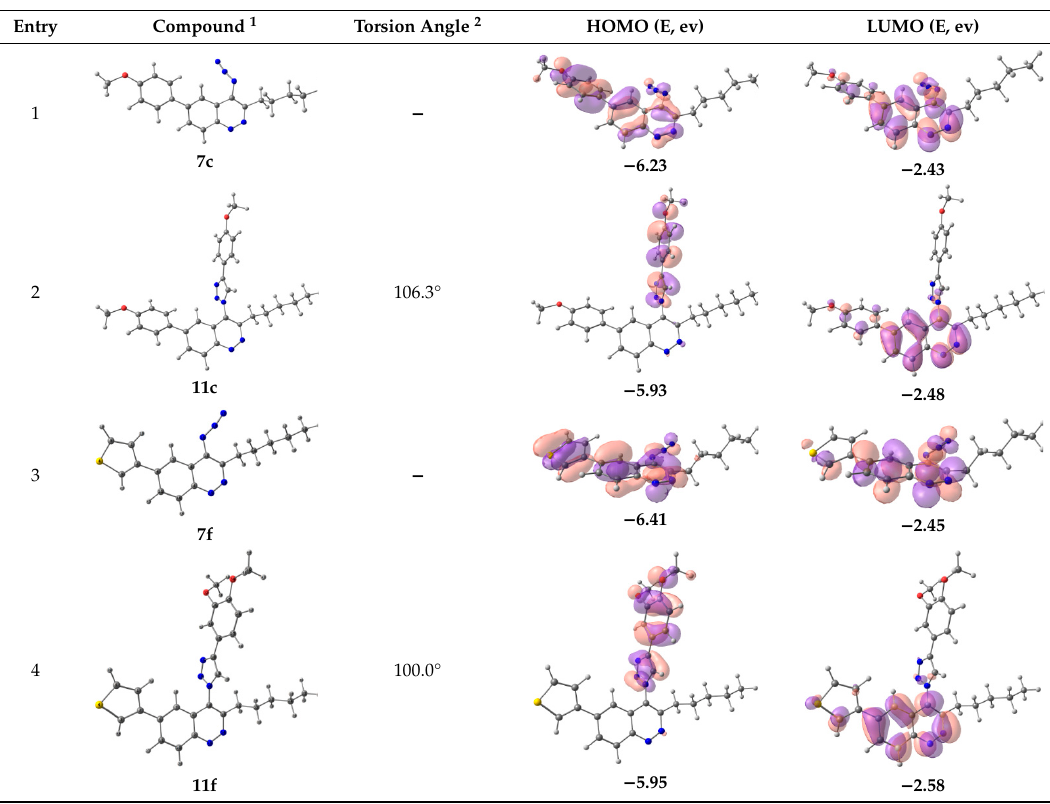
Table 2. Optimized geometries of azidocinnolines, triazolylcinnolines and their frontier molecular orbitals.